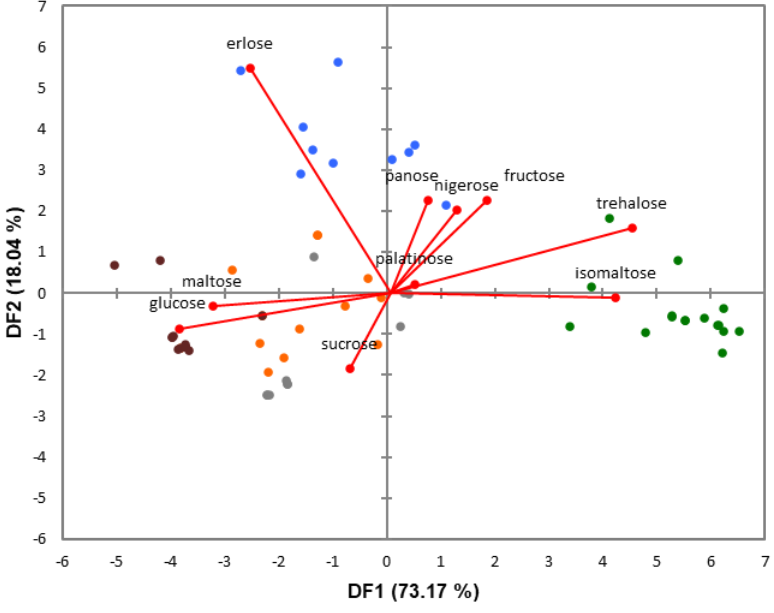
Figure 3. Linear discriminant analysis (LDA) biplot of honeys classified based on botanical origin.